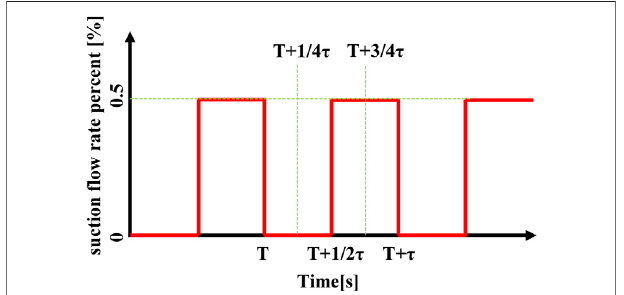
FIGURE 7 | Time de fi nition in a pulse periodicity.